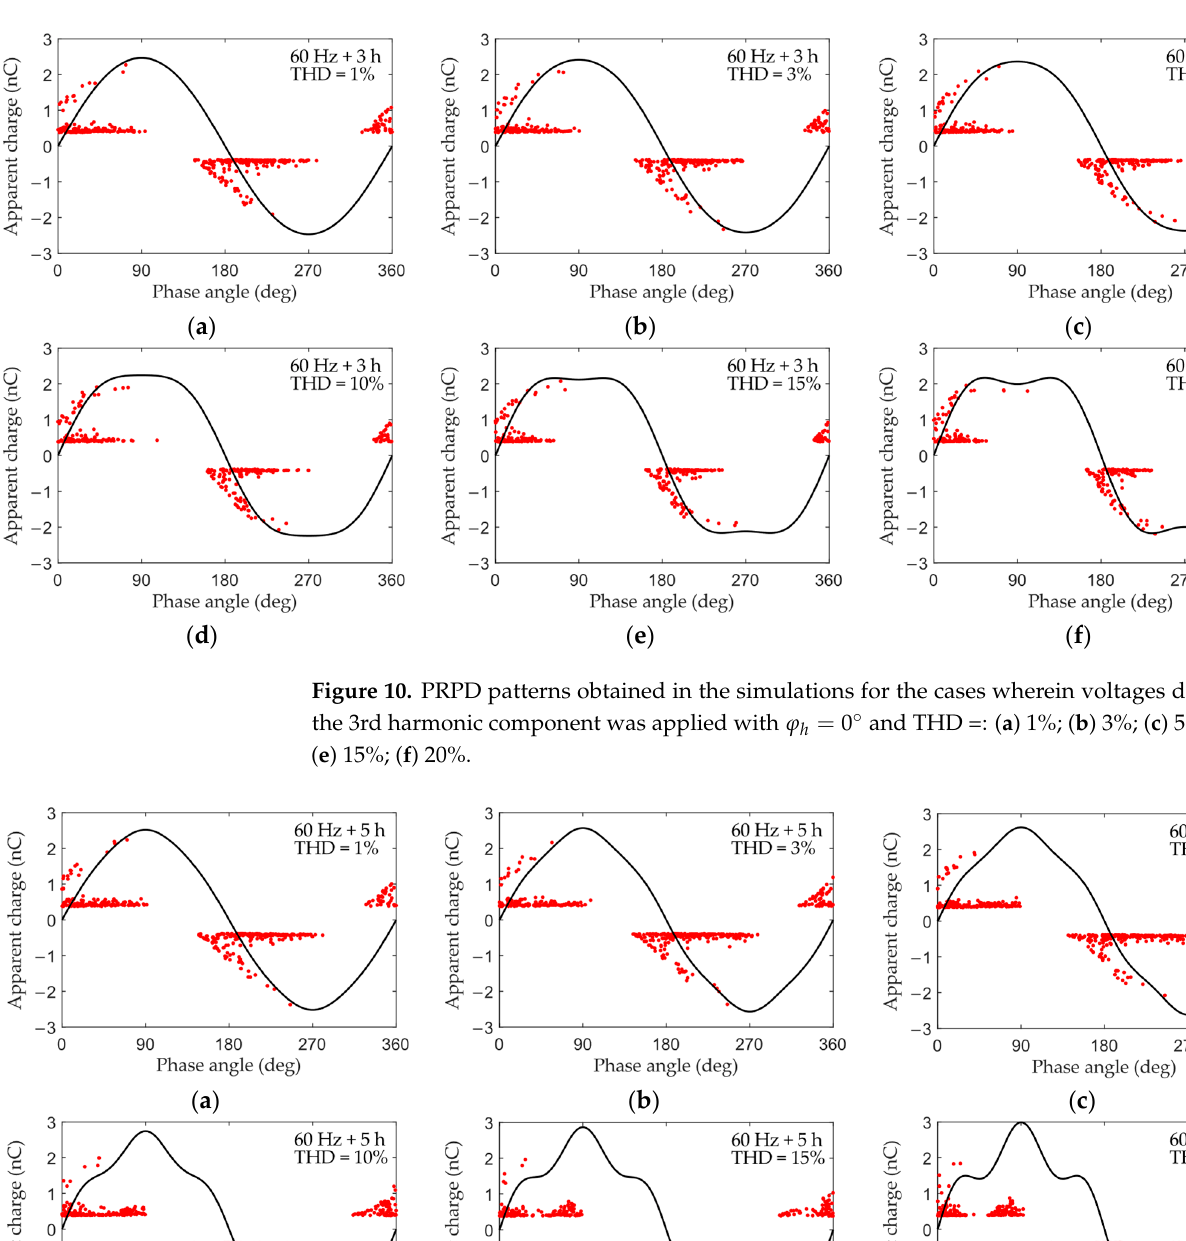
( f ) Figure 12. PRPD patterns obtained in the simulations for the cases wherein voltages distorted by the 7th harmonic component was applied with 𝜑 (cid:3035) = 0° and THD = : ( a ) 1%; ( b ) 3%; ( c ) 5%; ( d ) 10%; ( e ) 15%; ( f ) 20%. 4.3. Impacts of Changing the Third Harmonic Component Phase Angle on the PDs Characteristics The results presented in Section 4.1 showed that the mean number of PDs per cycle and the mean PDs apparent charges per cycle were reduced when the applied voltage was distorted by the third harmonic component. These results were obtained considering the third harmonic phase angle equal to 0°. However, it is known that due to the presence of non-linear loads and other disturbances in the electrical system, different types of